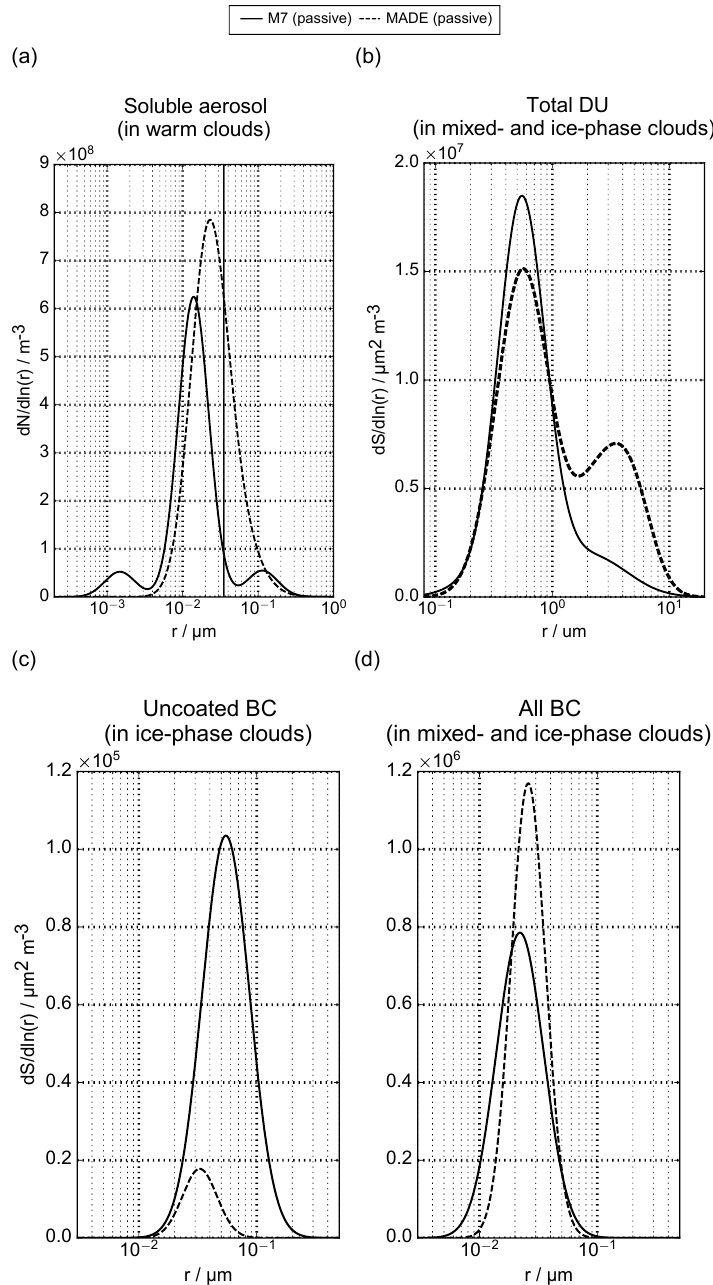
Figure 11: Size distributions of cloud-active aerosol for simulation passive using MADE and M7. Figure 11. Size distributions of cloud-active aerosol for the Passive simulation using MADE and M7. Shown are the CCN-relevant number Shown are the CCN-relevant number distribution of soluble aerosol in liquid clouds (a) as well as surface distribution of soluble aerosol in liquid clouds (a) as well as surface distributions of dust (b) and uncoated (c) and total soot (d) in the cloud distributions of dust (b) and uncoated (c) and total soot (d) in the cloud regimes where these species regimes where these species serve as INPs (Table serve as INP (Table 2). See Figure 3 for plot details. 24